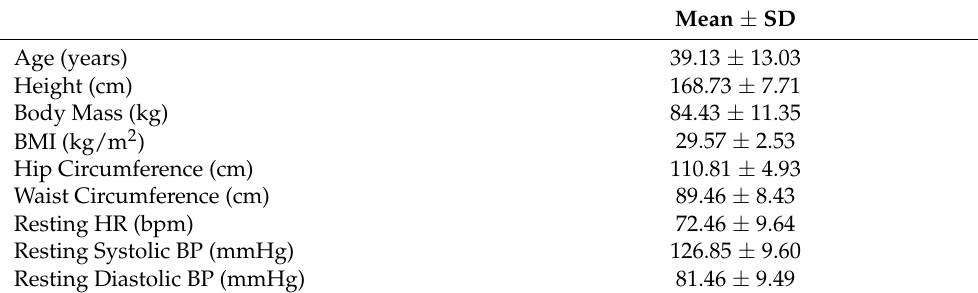
Table 1. Description of participants.